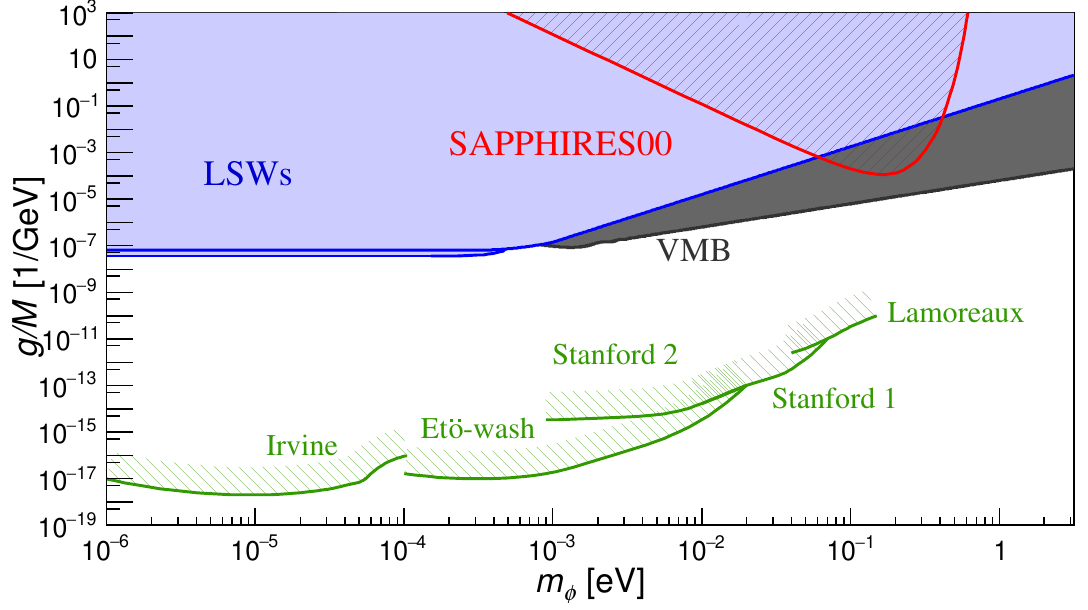
Figure 13 . Upper limits on coupling-mass relation for scalar field ( φ ) exchanges. The red shaded area labeled “SAPPHIRES00” is the region excluded by this work (stimulated resonant scattering). The light-blue area is the region for scalar fields excluded by the “Light Shining through a